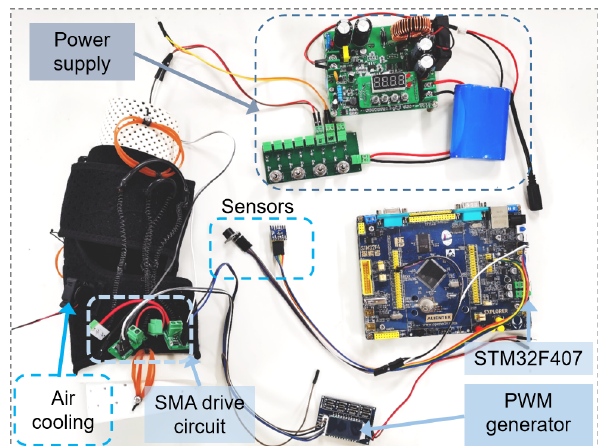
Figure 8. The experimental setup of